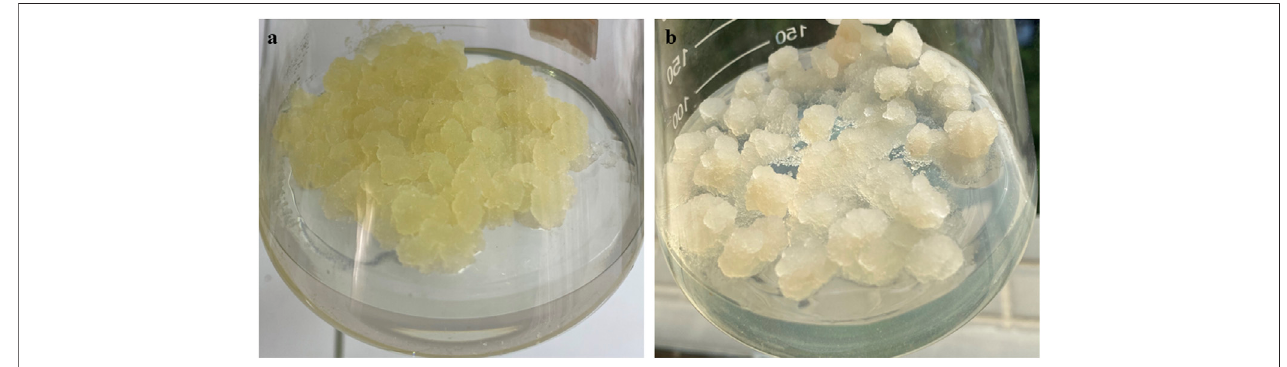
FIGURE 7 | The samples of 12-day-old (A) cambial meristematic cells (CMCs) and (B) dedifferentiated cells (DDCs) C. roseus that were used for the extraction of RNA extraction for transcriptome sequencing comparisons.